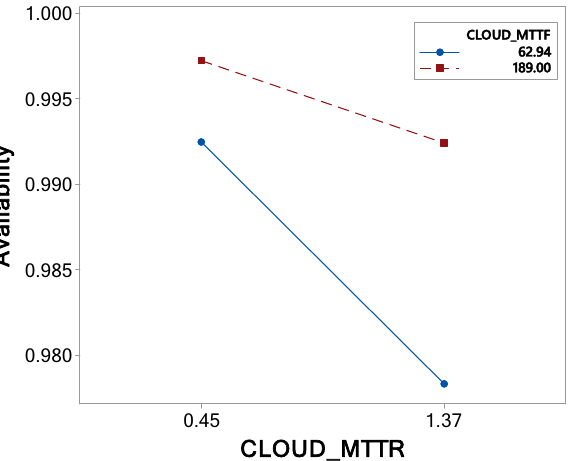
Figure 8. Interaction between MTTF and MTTR in the cloud and their impact on availability.